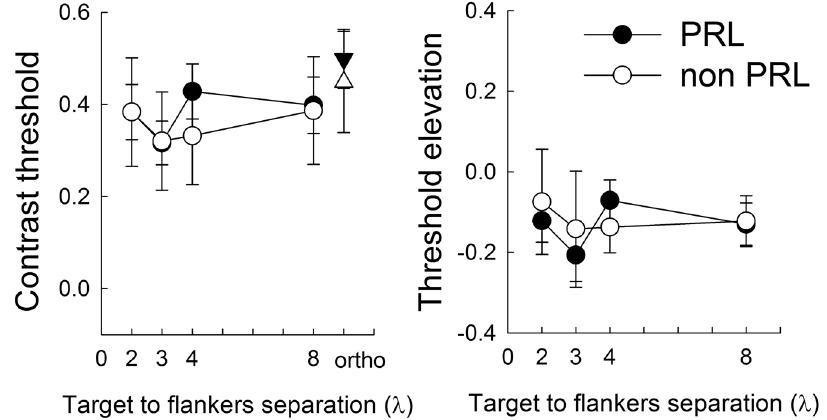
Figure 4. Contrast threshold and TE values (i.e., lateral interaction curves) as a function of target-to-flanker distance for 8 MD subjects in the PRL and non-PRL retinal positions. Contrast thresholds for the orthogonal configuration (8 λ ) are also shown. Bars indicate standard